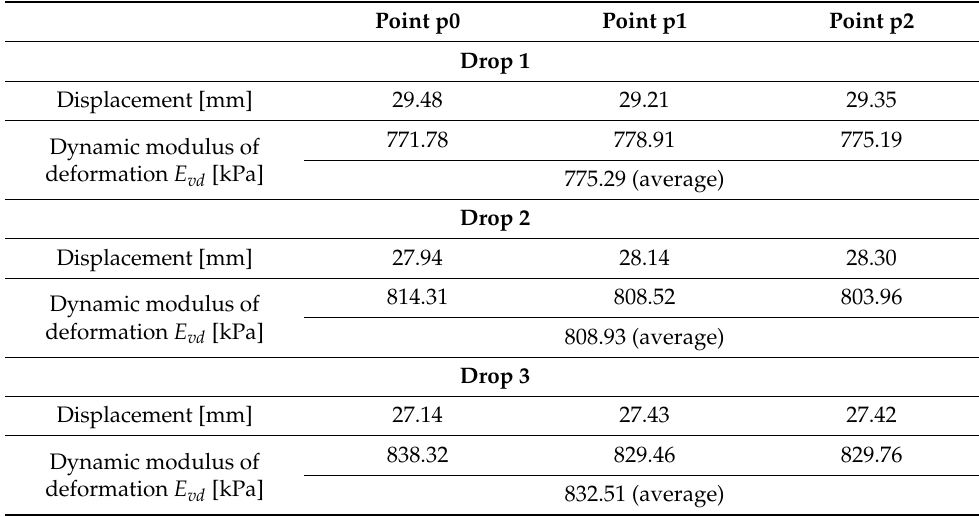
Table 4. The values of measured displacements and dynamic modulus of